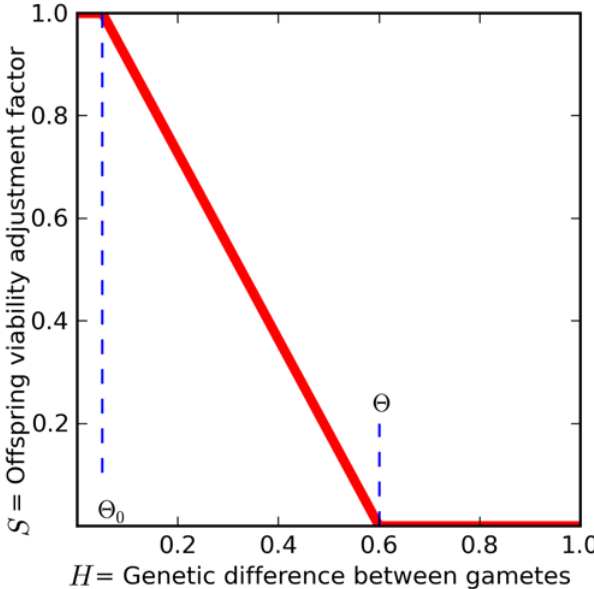
Figure 6. Virtual Genomics and Sexual Reproduction. Individuals are diploid hermaphrodites, in which haploid genomes consist of n =2 chromosomes containing l =200 nucleotide bases A, C, G, and T (only l =8 bases per chromosome shown in this diagram). Each parent produces a haploid gamete by randomly selecting one of the chromosomes from each diploid pair (blue portions of the parent). When producing a gamete, some random point mutations may also occur with a low probability m per site. One such mutation, from base C to base A, is depicted in red.